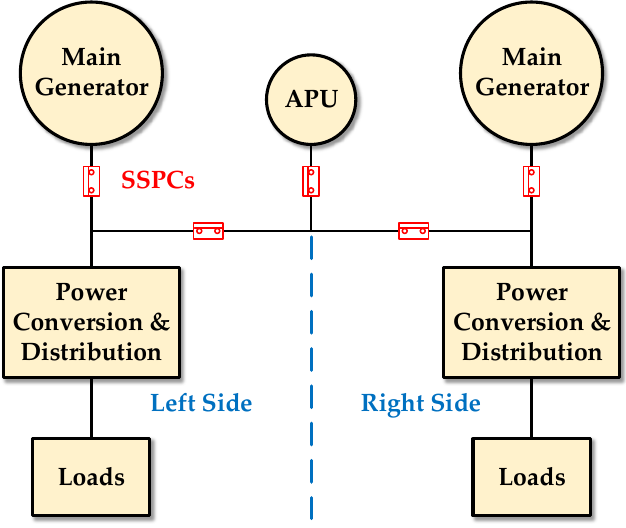
Figure 1. Basic architecture of the aircraft electric power system.